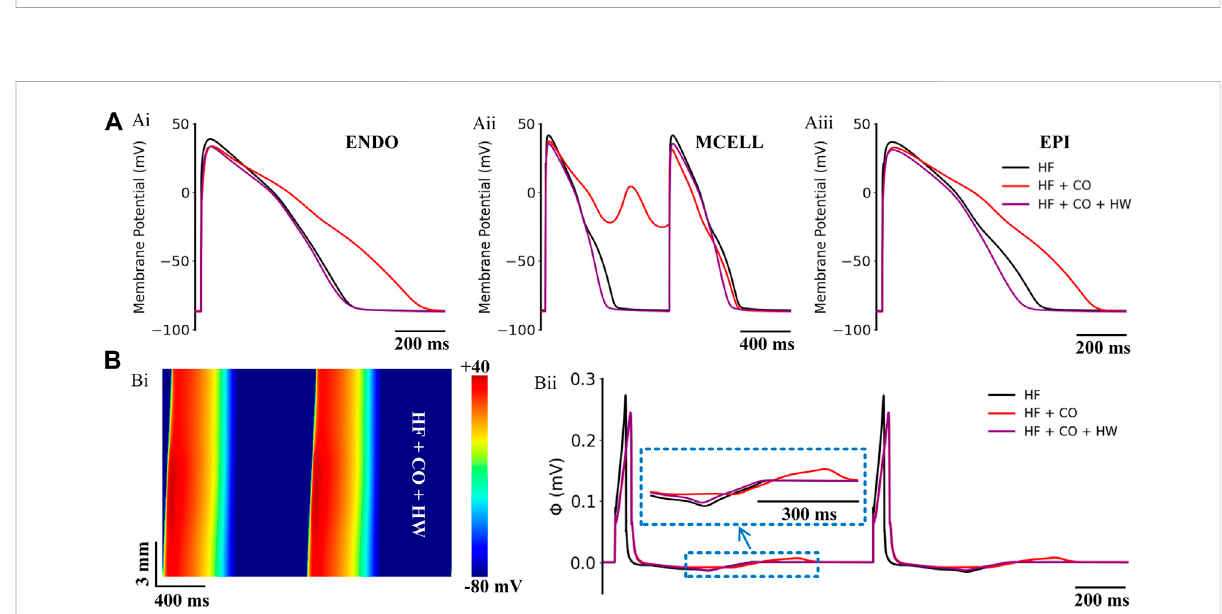
FIGURE 12 ActionsofHW-0168(HW)onCO-affectedmyocardialcellsandtissuesaccompaniedbyheartfailure. (A) Thecomparisonofactionpotentialsof three cell types under ‘ HF ’ , ‘ HF + CO ’ , and ‘ HF + CO + HW ’ conditions. (B) Spatial-temporal plots under the ‘ HF + CO + HW ’ condition (Bi), and the corresponding pseudo-ECGs